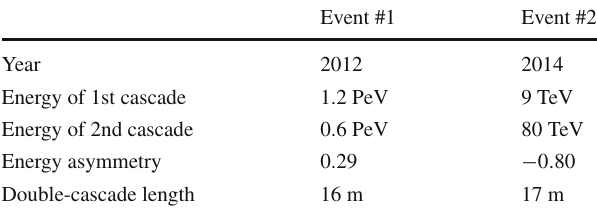
Table 2 Reconstructed properties of the two double cascades. Uncer- tainties are ∼ 10% for the deposited energy and ∼ 2 m for the double- cascade length